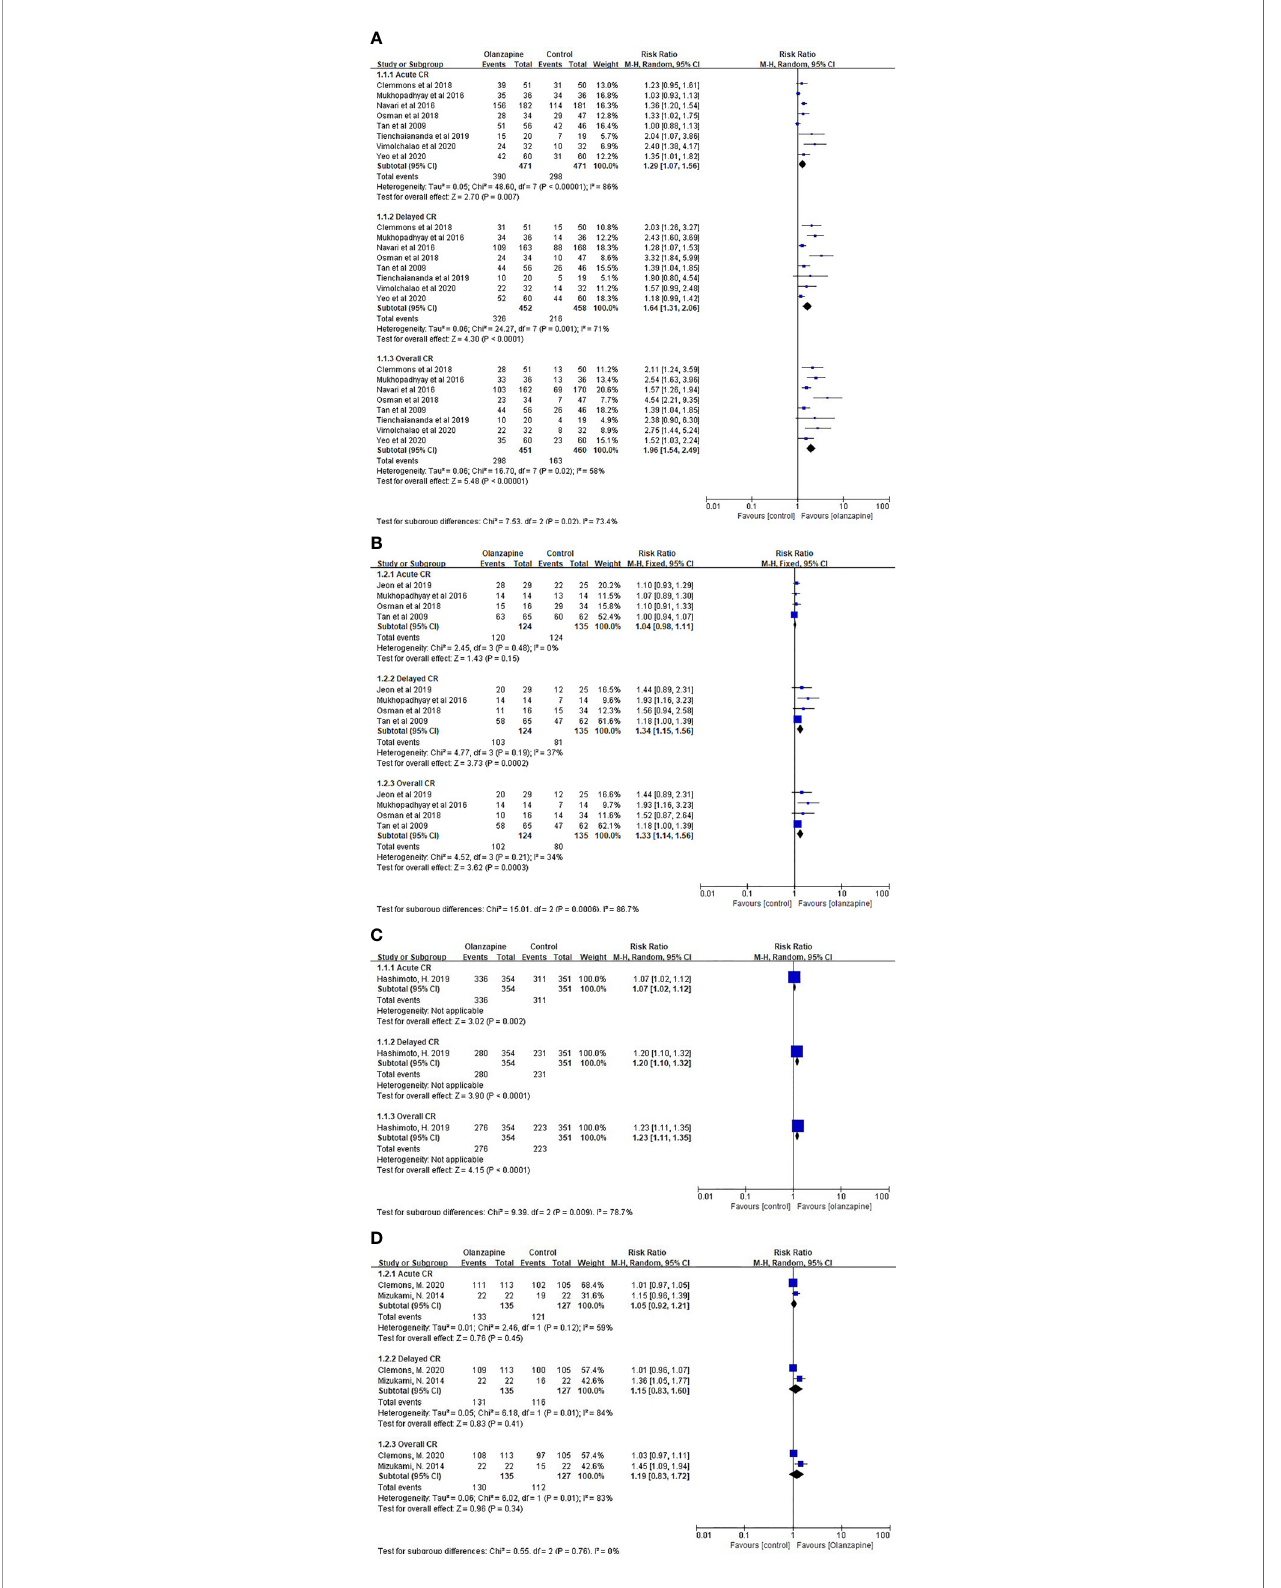
FIGURE 1 | Complete response (CR). (A) CR of 10mg Olz for HEC. (B) CR of 10mg Olz for MEC. (C) CR of 5mg Olz for MEC. (D) CR of 5mg Olz for